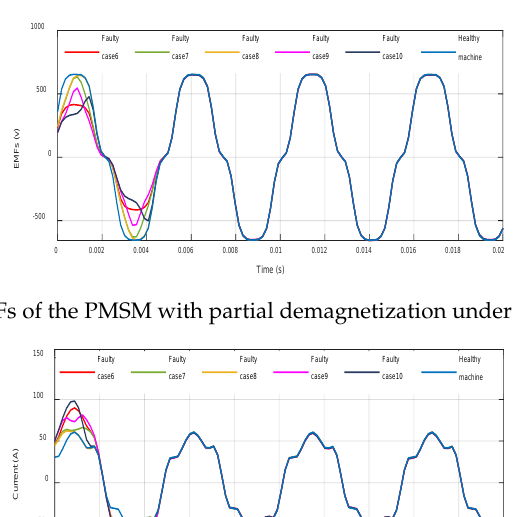
Figure 19. Flux linkage of the PMSM with partial demagnetization under different cases.